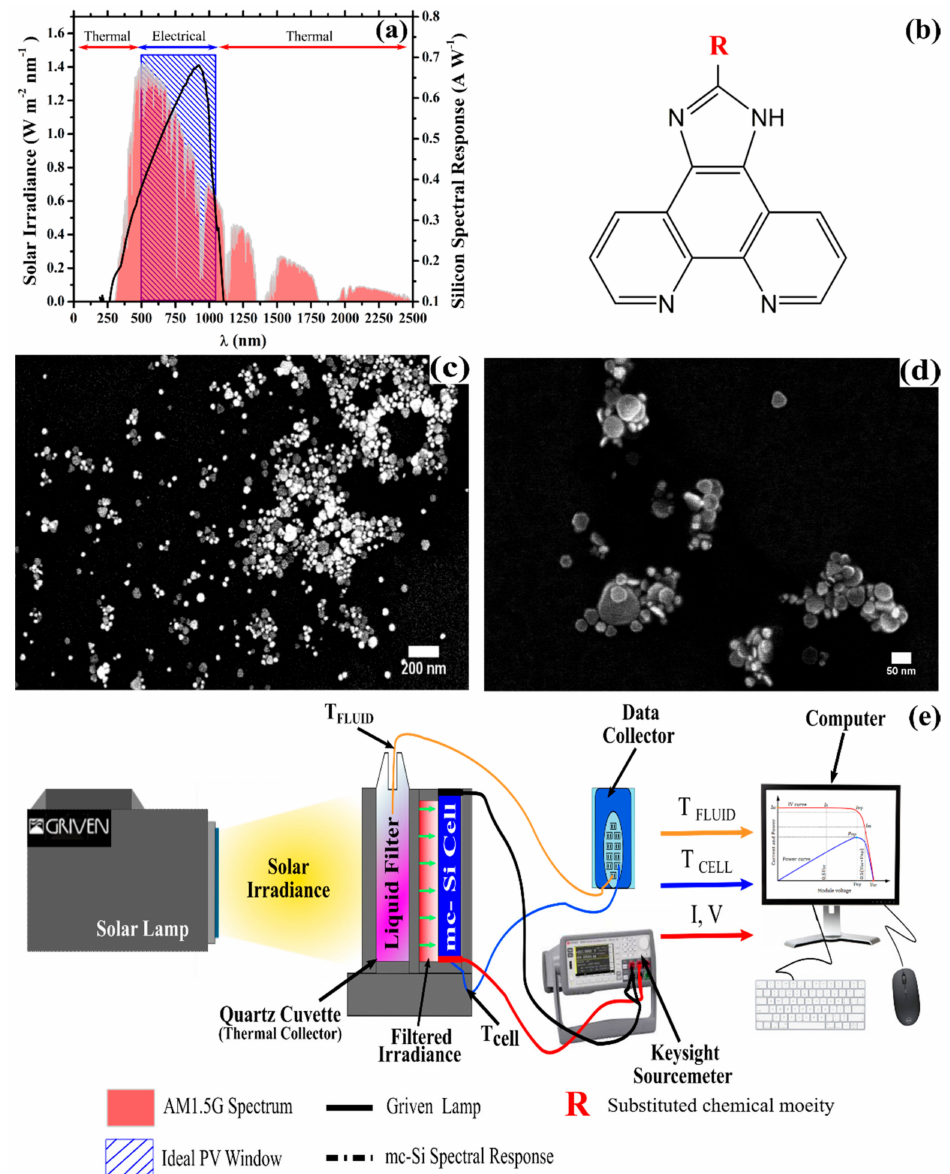
Figure 1. ( a ) Typical solar spectrum and its idealised photothermal (thermal) and photovoltaic (PV) (electricity) conversion spectral regions. The spectral window response of the monocrystalline silicon (mc-Si) and the ideal photovoltaic conversion spectral range for this technology (highlighted in blue) are shown for comparison. Small di ff erences between the two can be observed; ( b ) the general molecular structure underpinning the range of hybridised heat-transfer fluids considered in this study, where R indicates the substitution site for the specific chemical moieties outlined in Table 1; ( c ) scanning electron microscope (SEM) images (scale bar 200 nm) of the silver nanoparticles which contained particle sizes ranging from 10 nm to 85 nm; ( d ) SEM images (scale bar 50 nm) emphasising the extensive range of anisotropic particle morphologies including prisms, hexagons and other non-spherical geometries; ( e ) schematic representation of the experimental set-up used to evaluate the performance of a concentrator PV cell (C-PV) incorporating various liquid plasmonic-enhanced luminescent down-shifting (PLDS) filters designed for concentrated photovoltaic-thermal (C-PVT) systems. The photo-thermal properties were monitored